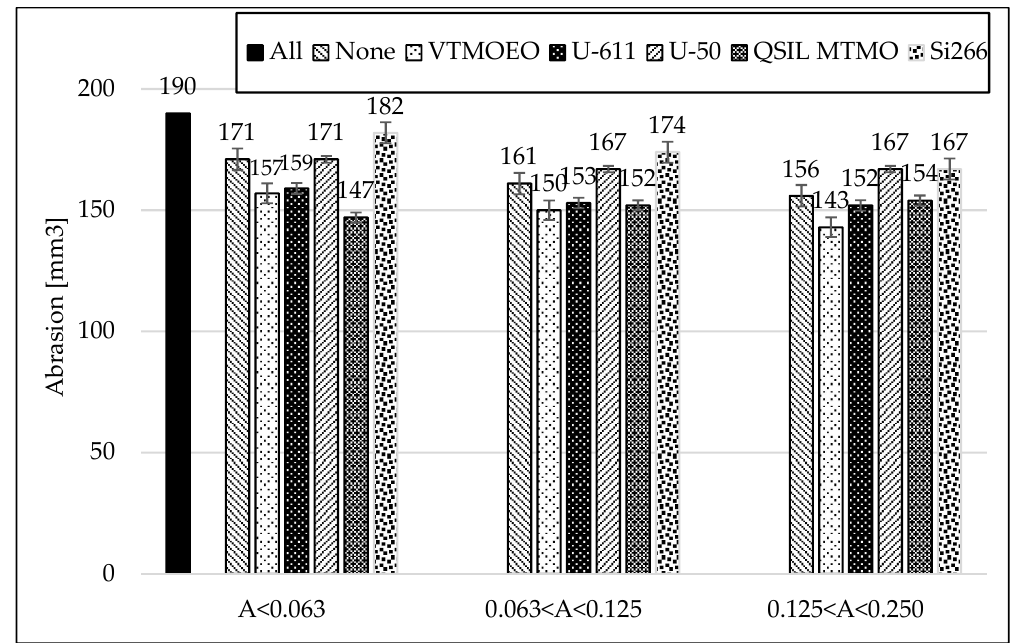
Figure 11. Influence on the silanization of fly ash with various silanes on abrasion of the rubber vulcanizates filled with CB and different FA fractions.